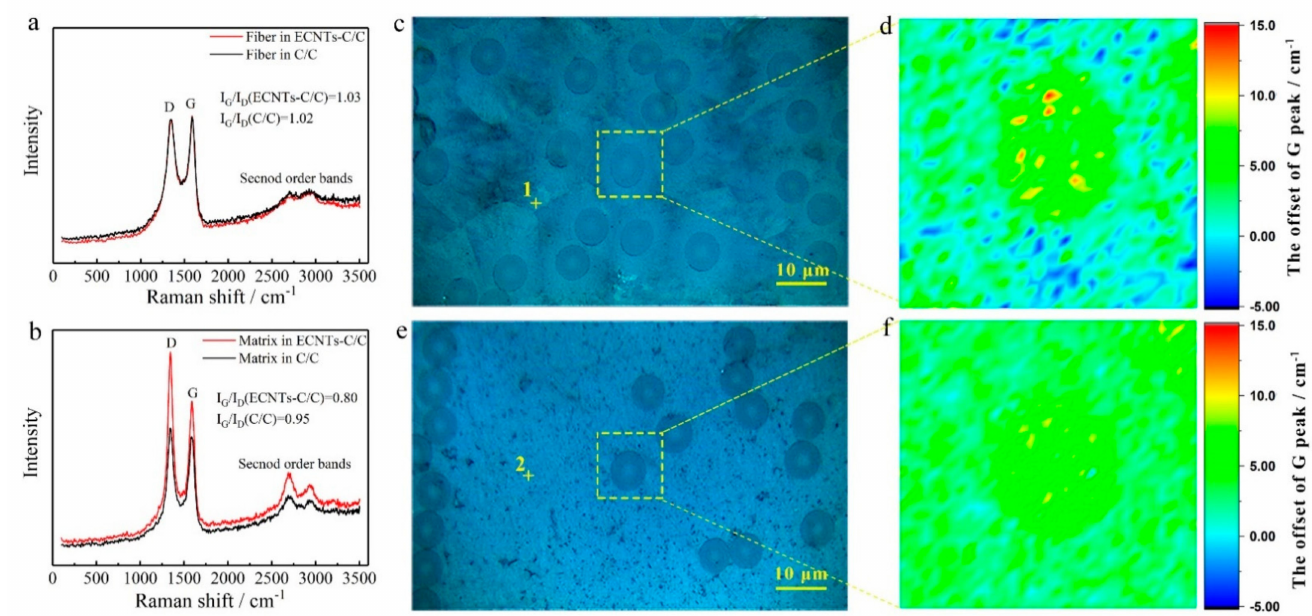
Figure 5. Raman spectra analysis: ( a ) Carbon fibers in C/C and CC/C composites before densification; ( b ) Matrix in C/C (Point 1) and CC/C (Point 2) composites after densification process; ( c , e ) Optical micrographs of C/C and CC/C composites; ( d , f ) Raman mapping of the shift of G peak, reflecting the stress distribution in carbon fiber in C/C and CC/C